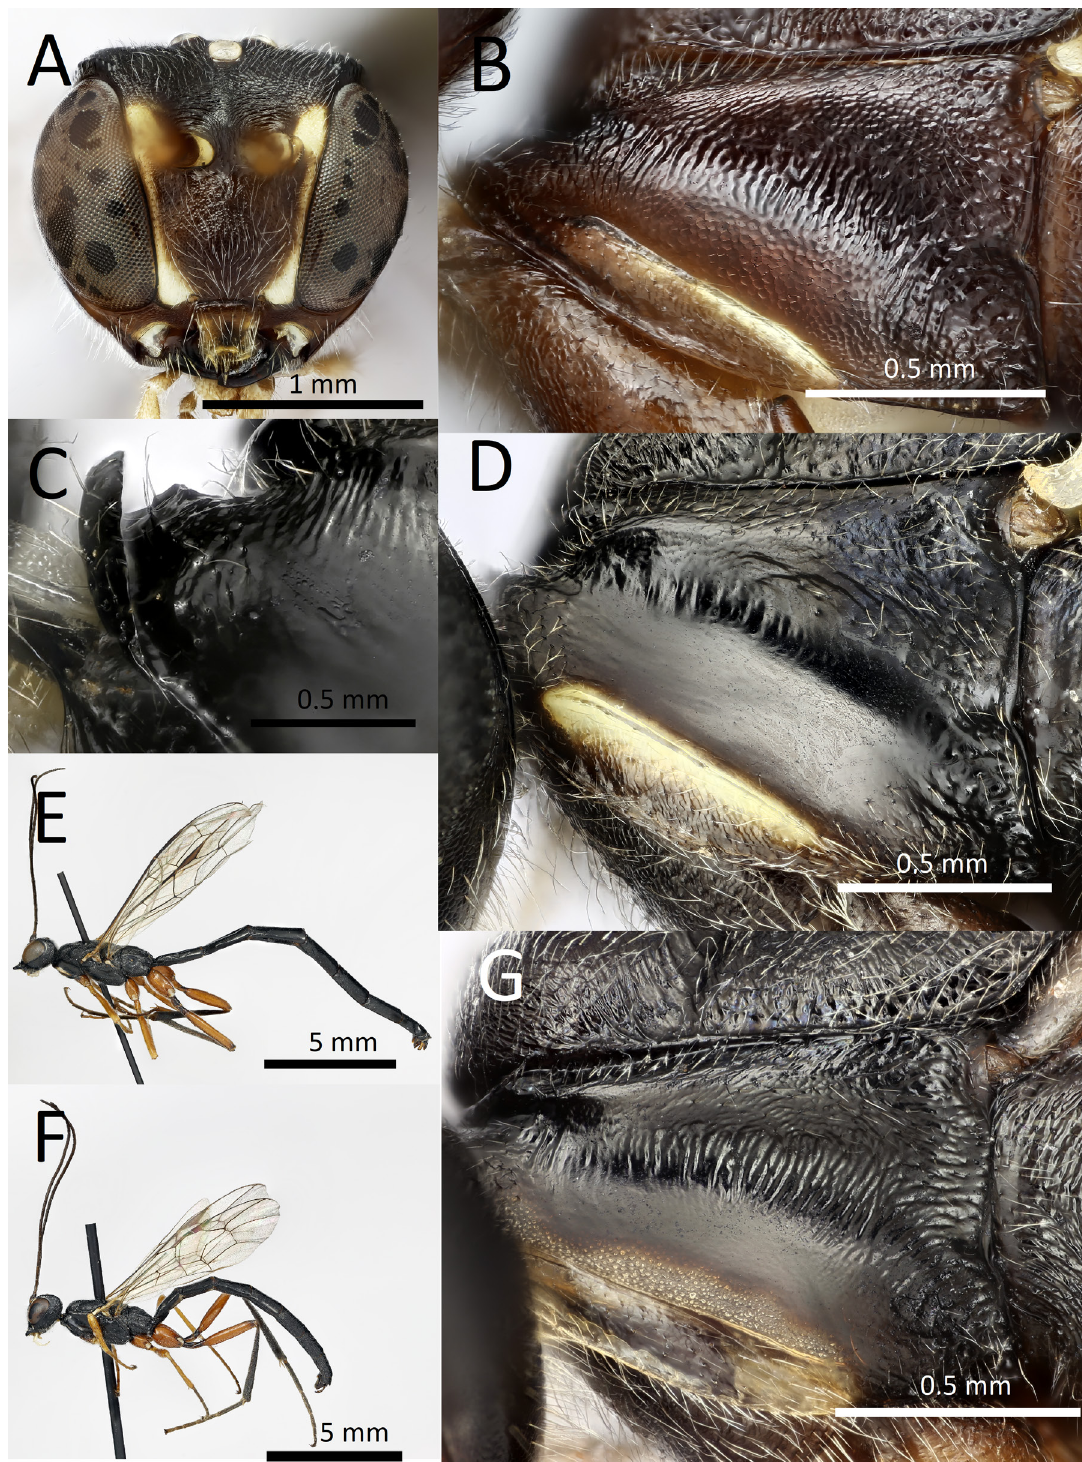
Fig. 5. A . Neoxorides varipes (Holmgren, 1860), ♀, MZH, head, anterior view. B . N. varipes , ♀ (MZH), pronotum, lateral view. C . N. nitens (Gravenhorst, 1829), ♀ (NJ), central anterior part of pronotum, lateral view. D . N. collaris (Gravenhorst, 1829), ♀ (NJ), pronotum, lateral view. E . N. nitens , ♂ (NJ), form with long metasoma, lateral view. F . N. nitens , ♂ (NJ), form with short metasoma, lateral view. G . N. montanus (Oehlke, 1966), ♀ (NJ), pronotum, lateral view. Photos: Alexander